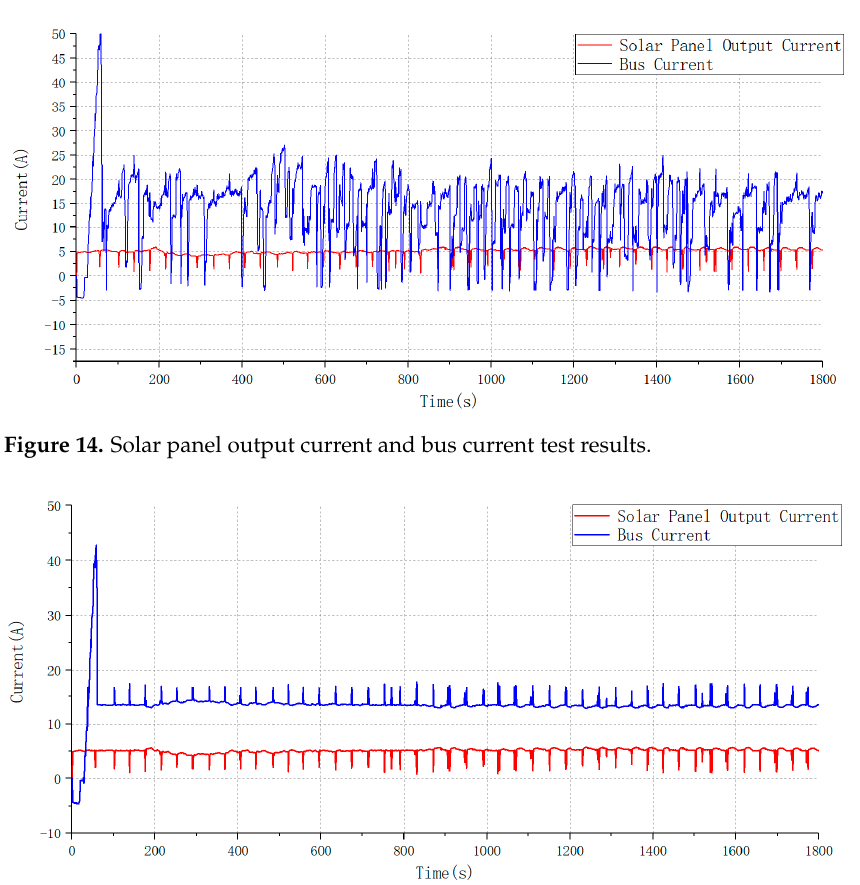
Figure 15. Solar panel output current and bus current simulation results.